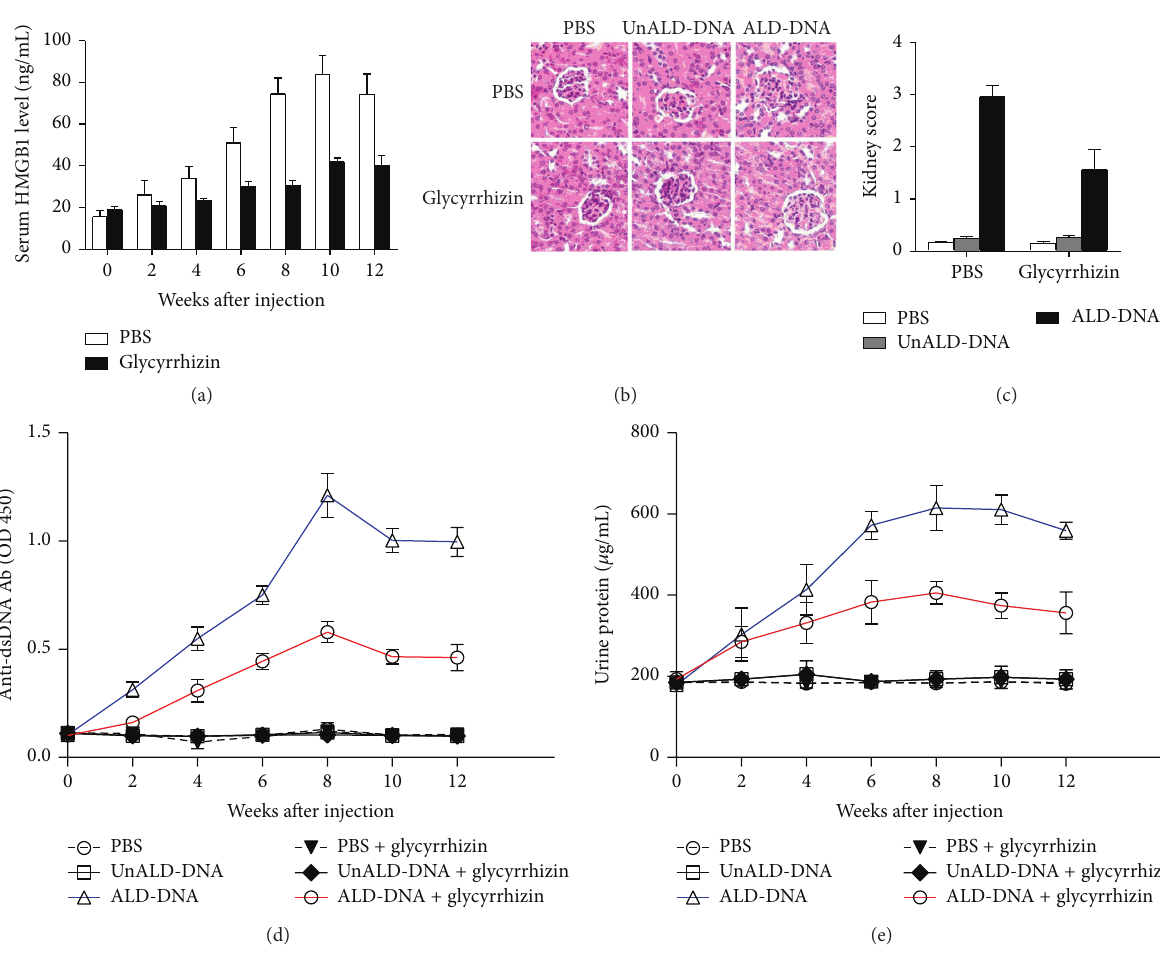
Figure 3: Inhibition of HMGB1 function could ameliorate the severity of SLE. BALB/c mice were administrated intramuscularly injected with glycyrrhizin (0.5 mg/mouse) or PBS to inhibit HMGB1 function. 72 h after injection, mice were then injected subcutaneously with ALD-DNA (50 𝜇 g/mouse) for total 3 times in 4 weeks. (a) The dynamics of serum HMGB1 levels were determined by ELISA every 2 weeks after initial injection. Data are means ± SD from 8 mice in each group. (b) Nephritic pathology was evaluated by H&E staining of renal tissues. Images (magnification × 200) are representative of at least 8 mice in each group. (c) The kidney score was assessed using paraffin sections stained with H&E in (b). ( 𝑛 = 8 ). (d) Serum anti-dsDNA antibody levels were measured by ELISA every 2 weeks after initial injection. Data are means ± SD from 8 mice in each group. (e) Urine protein levels of the mice were assessed by BCA method every 2 weeks. Data are means ± SD from 8 mice in each group. ∗ 𝑃 < 0.05